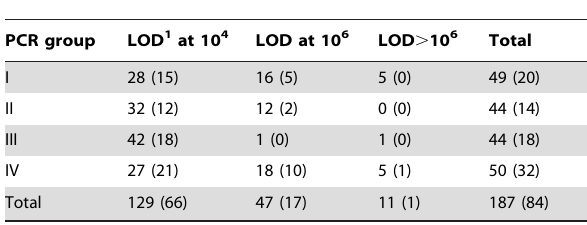
Table 3. Summarized results of RPM-TEI sensitivity